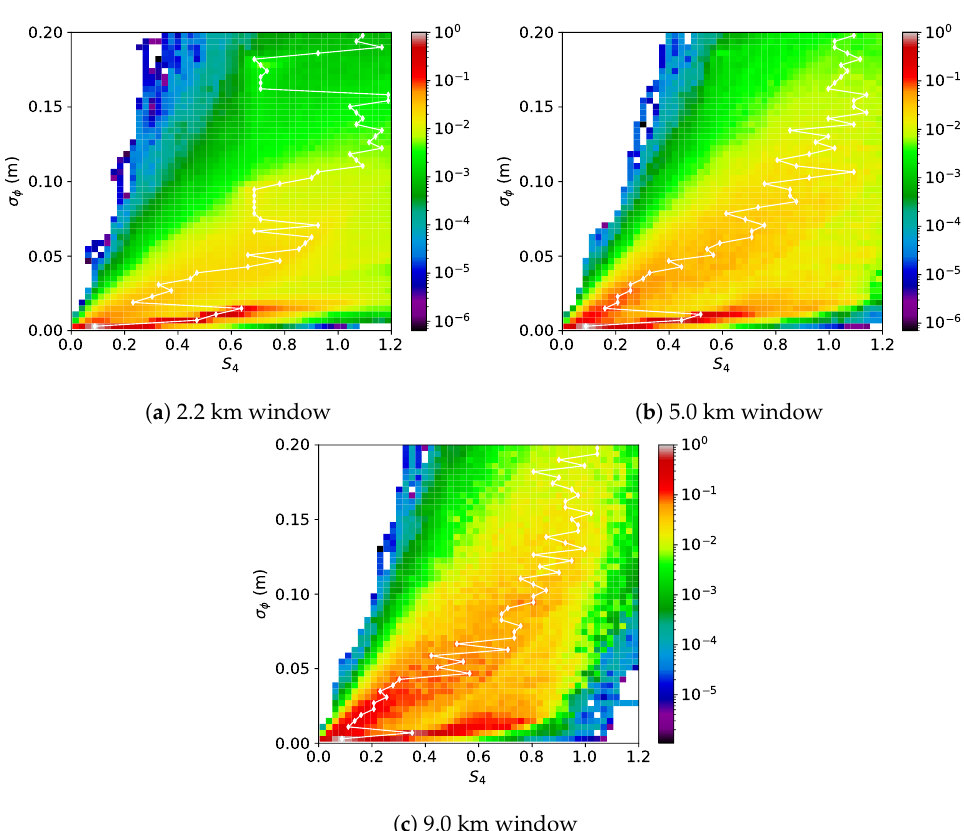
Figure 9. Simulated S 4 - σ φ histograms using 10,000 randomly sampled E s parameters with the addition of turbulence to the Gaussian